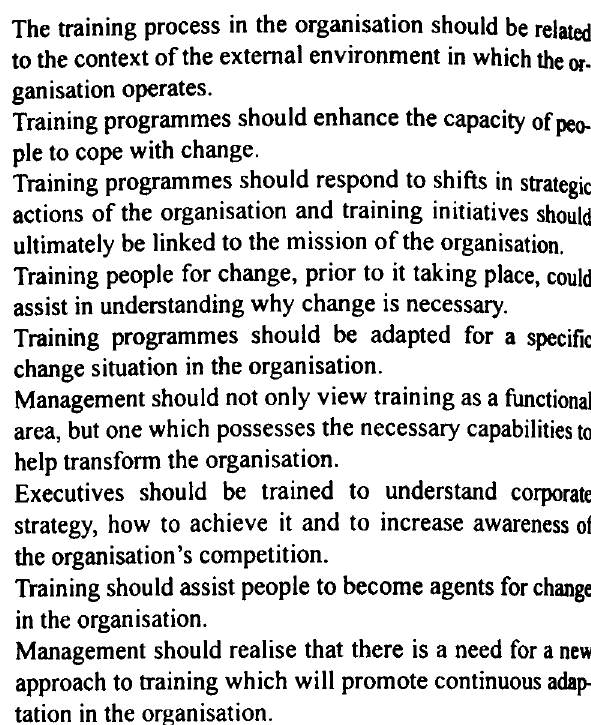
Table 4 Pearson product-moment correlation coefficients: Section A and B of the